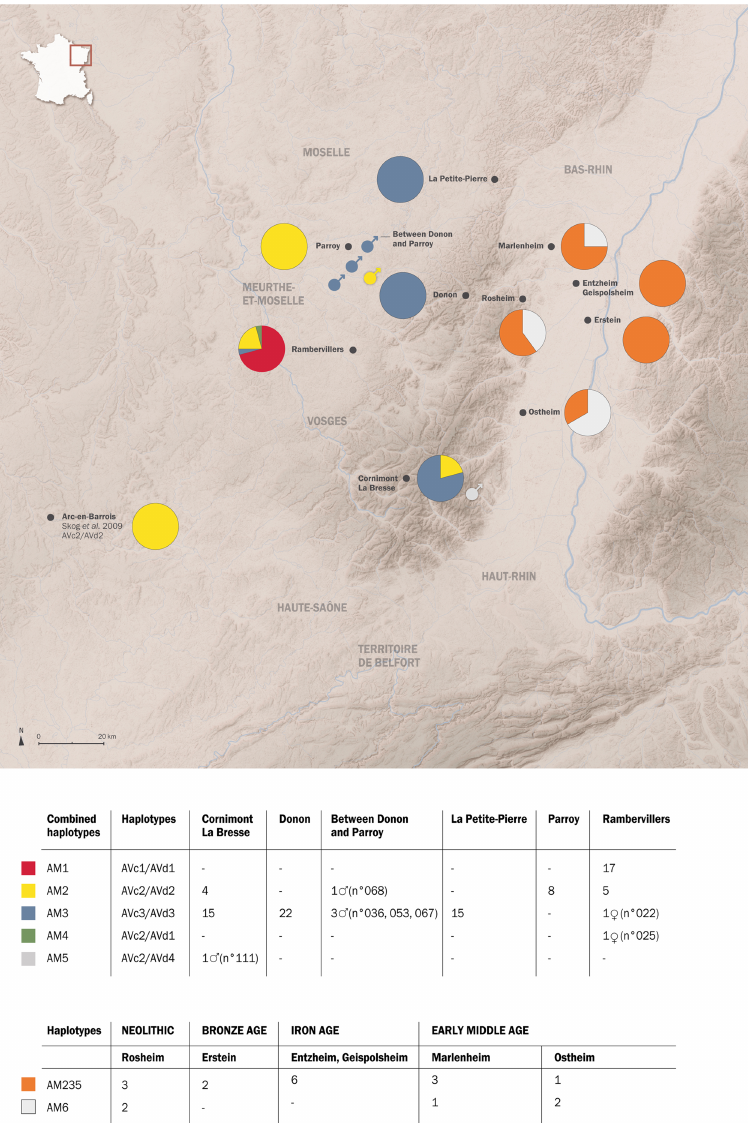
Fig 1. Modern and archaeological study sites and distribution of ancient and contemporary red deer mtDNA haplotypes in north-eastern France. Pie charts on the right side show the relative distributions of ancient haplotypes AM235 and AM6, based on concatenated cyt b and d-loop 256 bp. Pie charts on the left side show the relative distribution of modern haplotypes (AM1 to AM5) based on combined 680 bp cyt b and 785 bp d-loop sequences. The sex of modern male samples is added when they are culled near or in a territory from which they are not originated. Drawing: Delphine Souan, Arche´ologie Alsace, France (Maps ASTER,